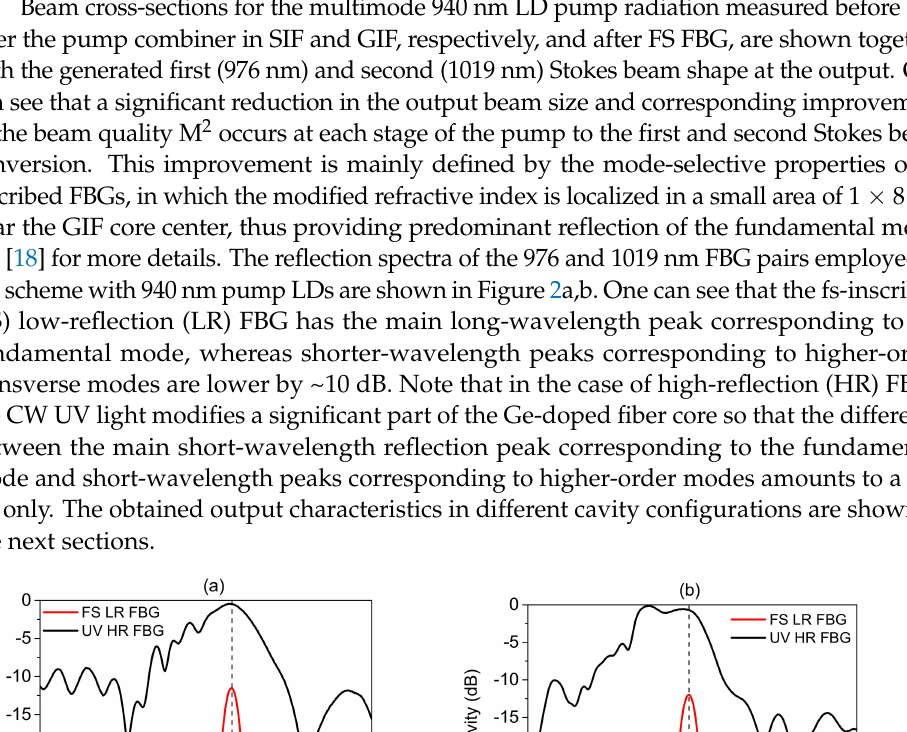
Figure 1. Cascaded Raman laser scheme based on multimode LD-pumped fiber: LD1-3 are laser diodes pigtailed by step-index fiber (SIF) with 100 µ m core and combined by a pump combiner; GIF is 1 km Raman graded-index fiber with 100 µ m core in which an UV-inscribed highly reflective (R~90%) fiber Bragg grating (UV FBG) and a fs-inscribed output coupler (R~4%) (FS FBG) form a cavity at wavelengths corresponding to the 1st and the 2nd Stokes waves. The laser output is collimated by a lens and characterized by a power meter (P), beam profiler (M 2 ) and optical spectrum analyzer (OSA), with the use of corresponding interference filters (IF) for selection of either the pump or the 1st and 2nd order Stokes beams. Pump beam profiles measured before and after pump combiner in SIF and GIF, respectively, and after FS FBG, are shown together with the generated 1st and 2nd Stokes beam shapes.